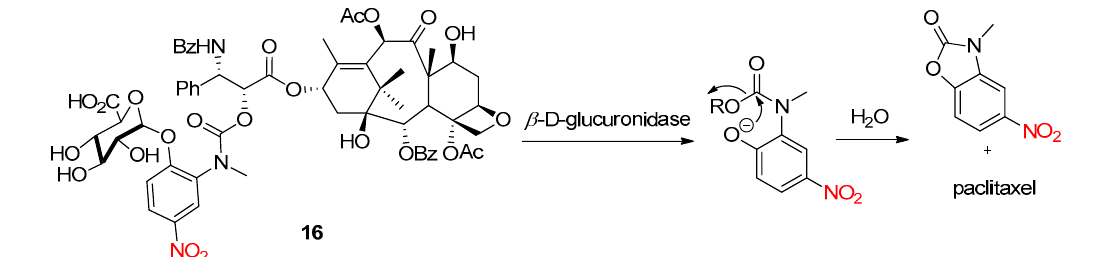
Scheme 20. Release of paclitaxel from prodrug 16 after β -D-glucuronidase activation and self-immolation of the nitro-containing linker.